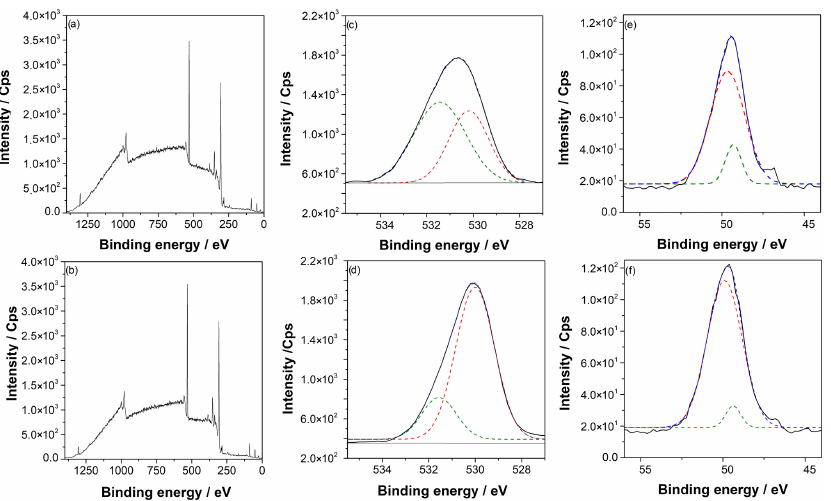
Figure 2. ( a ) Survey spectra for AZ samples, ( b ) survey spectra for AZ + Ar-P samples, ( c ) high- resolution XPS of O 1s spectra for AZ samples, ( d ) high-resolution XPS of O 1s spectra for AZ + Ar-P samples, ( e ) high-resolution XPS of Mg 2p spectra for AZ samples, and ( f ) high-resolution XPS of Mg 2p spectra for AZ + Ar-P samples.